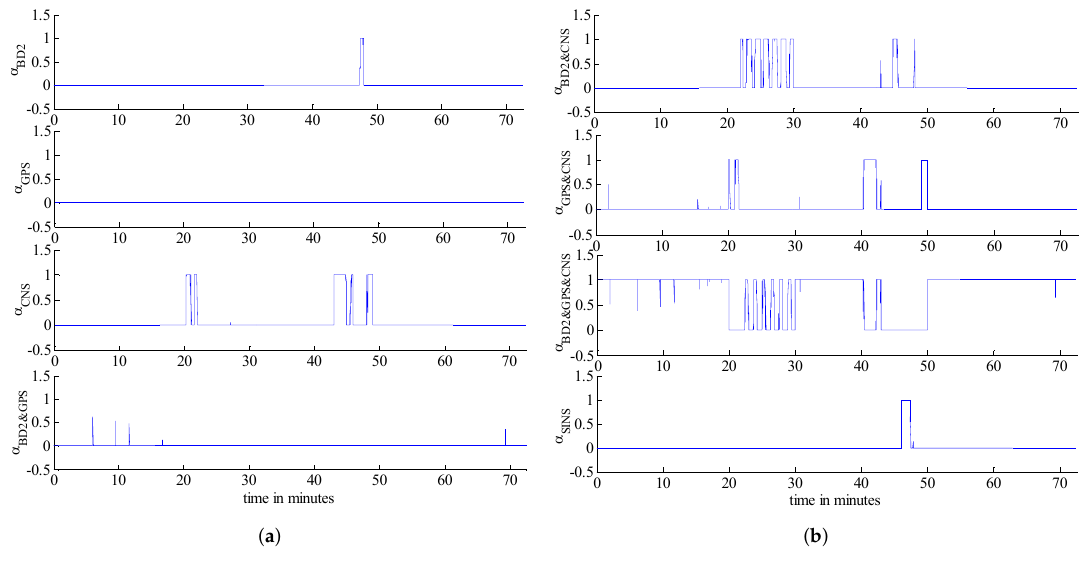
Figure 14. Sub-system weights ( a ) weights1; ( b )